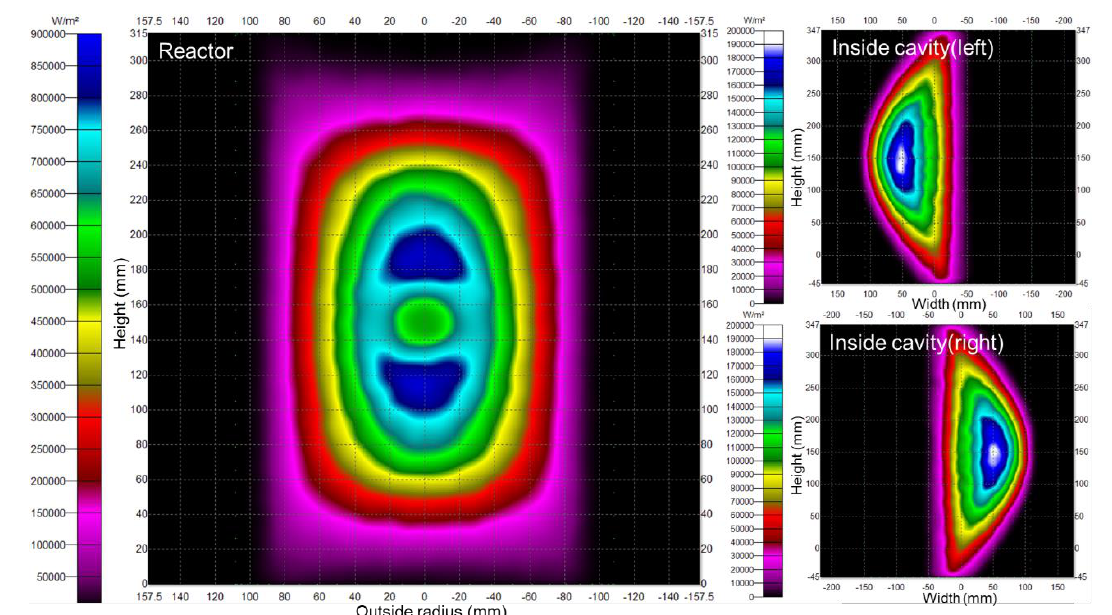
Figure 14. Heat flux (W/m 2 ) distributions obtained from optic calculation (full cavity).